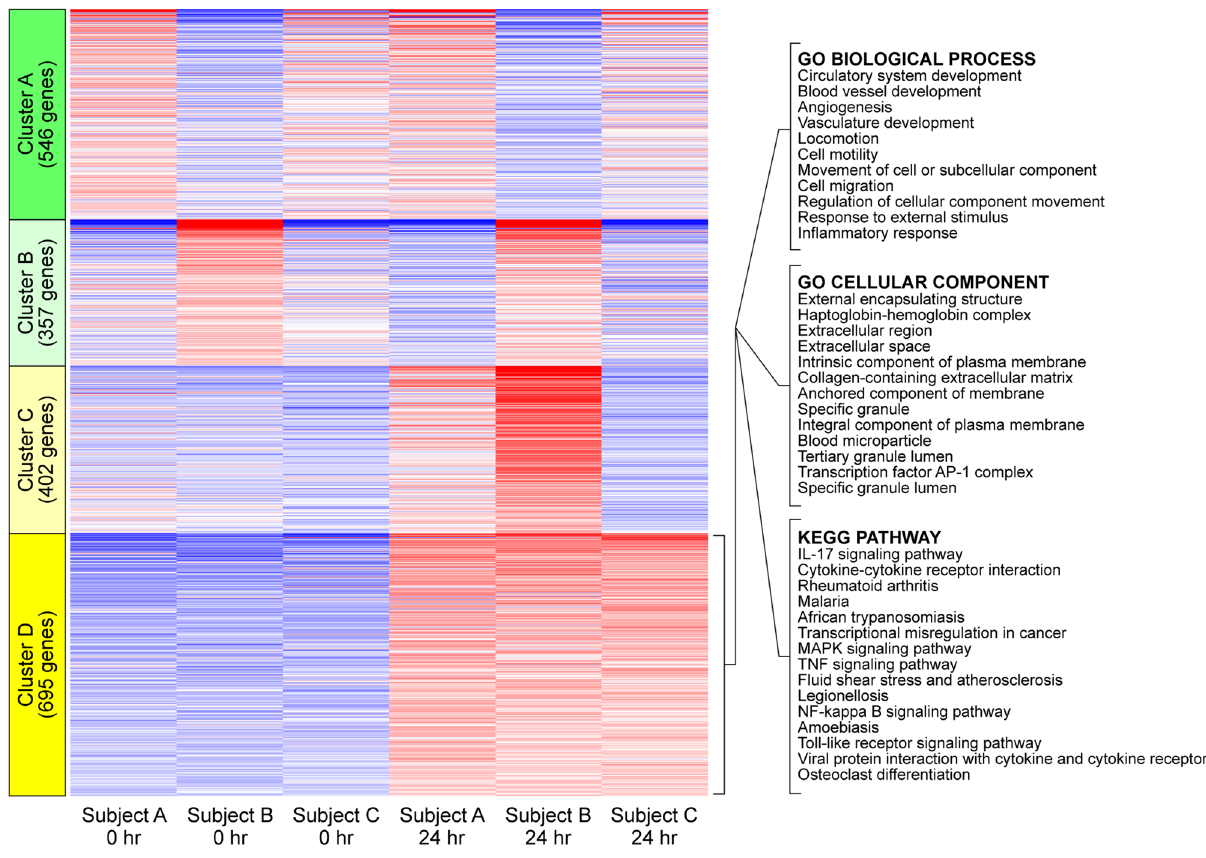
Figure 3. Exposure to overnight shipping conditions induces a transcriptional response in PBMCs. PBMCs were isolated from whole blood from 3 healthy controls at 0 or 24 h. RNAseq was used to characterize transcriptional changes. K-means clustering revealed 4 clusters in the 2000 most variable genes. Of these, only cluster D exhibited a uniform pattern of change at 24 h relative to 0 h in all 3 subjects, consistent with a transcriptional response associated with the handling conditions rather than inter-individual differences. Pathway analysis of the 695 genes in this cluster identified processes associated with signal transduction and inflammation. Transcriptional changes are heatmapped from blue (strongly downregulated) to red (highly in recovered neutrophils by this timepoint. Since the total number of HLADR - CD3 - CD66b + CD14 lo CD16 hi neu- trophils in whole blood did not markedly change over time (Fig. 1) and given that negative selection based on removal of cells expressing non-granulocytic markers was used to isolate the cells, the reduction in neutrophils observed in Fig. 2 likely arises from a change in immunophenotype (for example, increased CD14 expression) or an increase in non-specific “stickiness” due to activation or death. Peripheral blood mononuclear cells upregulate inflammatory, stress, and cell death pathways after overnight shipping. We assessed the transcriptional impact of holding blood at ambient tempera- ture by isolating PBMCs and performing bulk RNA-seq (Supplemental Table 1). We compared the transcrip- tional profiles from 3 healthy donors (female age 29, female age 33, male age 52) in PBMCs prepared imme- diately after blood collection (0 h) and PBMCs prepared after holding the blood at ambient temperature for 24 h. Transcript read counts for 16,491 genes per subject per timepoint that passed initial quality control were analyzed by K-means clustering of the 2000 most variable genes (Fig. 3). Of the 4 clusters, only one (cluster D) exhibited uniform transcriptional changes in all 3 subjects, consistent with a gene set that was influenced spe- cifically by the handling conditions rather than by inter-individual biological variations. The 695 genes in this cluster mapped to gene ontology biological processes and cellular components associated with blood cell devel- opment and function, adhesion and cellular movement, and inflammation. Relevant KEGG 15 pathways involved cytokine and chemokine signaling. Analysis of differentially expressed genes (DEGs) in common across the three subjects using DEseq2 16 on all 16,491 genes revealed that only 929 genes were upregulated more than twofold (FDR < 0.05) and only 215 genes were downregulated to the same extent (Supplemental Table 2; Sup- plemental Fig. 1). Weighted correlation network analysis 17 further revealed 178 strongly regulated genes as part of a co-expression network (Table 3). Gene set enrichment analysis 18 identified 10 enriched pathways, several of which were associated with inflammatory signaling (Table 4). Finally, weighted network analysis 19 identified a